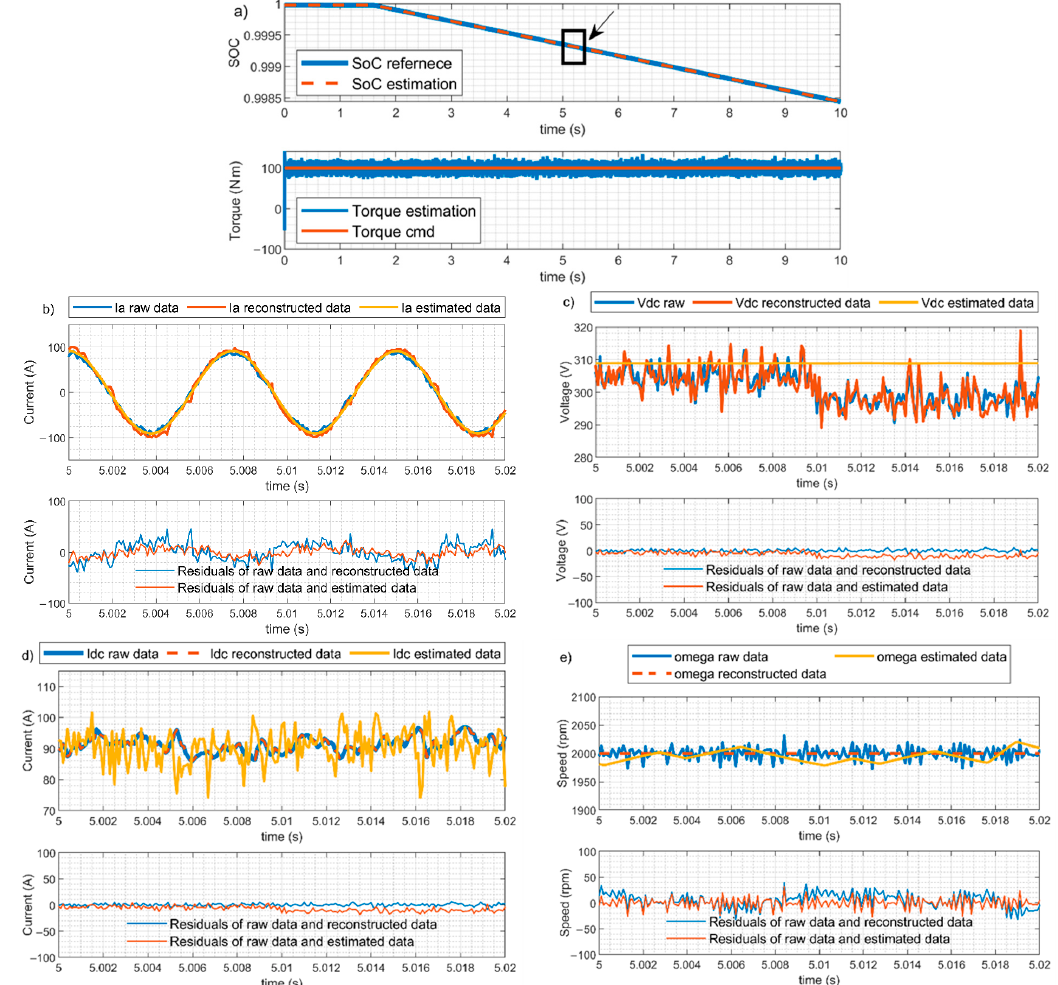
Figure 12. System response for each sensor when healthy. ( a ) Estimated and reference values of SoC and motor torque; ( b ) phase A current signal and its residual; ( c ) DC bus voltage signal and its residual; ( d ) DC bus current signal and its residual; ( e ) rotor speed signal and its residual.